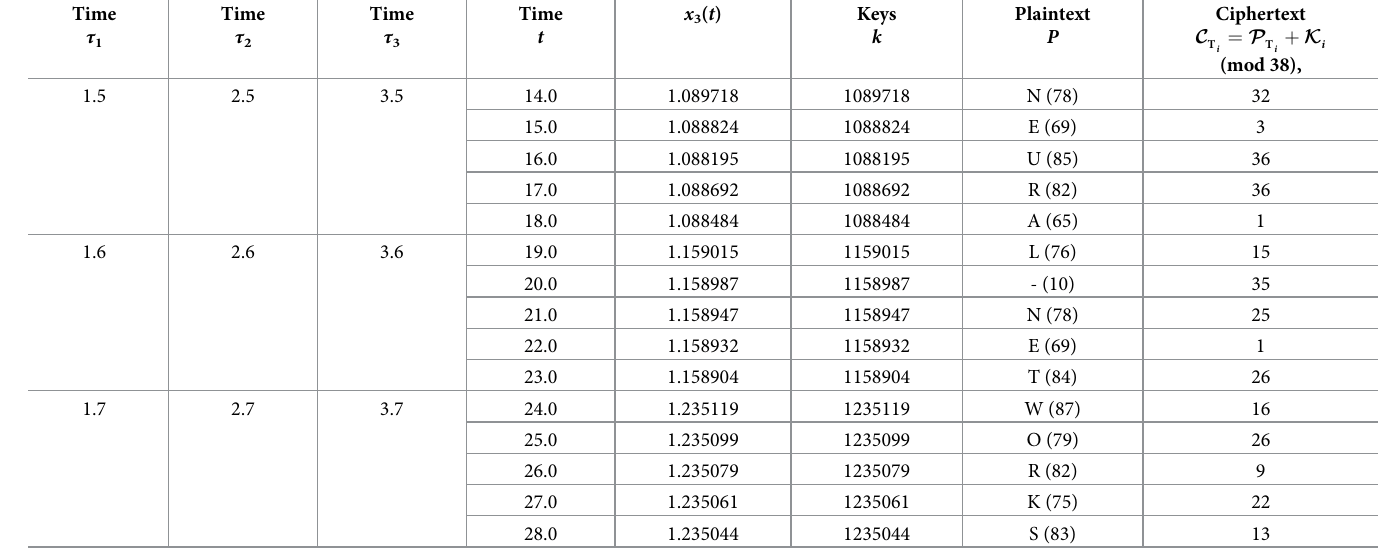
Fig 10. Phase portrait of x ð t Þ and y 3 ( t ) of multi-FONNSMD synchronization with multi-time delay [ τ 1 , τ 2 , τ 3 ]. (a) 3 [1.5,2.5,3.5], (b) [1.6,2.6,3.6], and (c) [1.7,2.7,3.7]. https://doi.org/10.1371/journal.pone.0270402.g010 about dynamic error synchronization based on examples 1–3 for various parameter values, fractional-order, and different types of time-delay at specified time values. Because neurons have varied communication delays, we study the non-identical multi-FONNSMD with other parameters and various time-delays. Based on the literature, fractional-order influences the system’s performance in chaotic dynamics. As formerly proven, parameters and time-delay Table 6. Encryption of PTEXT to